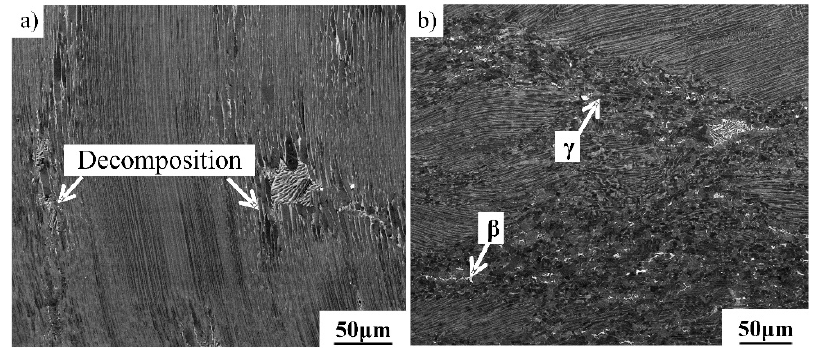
Figure 5. The e ff ect of deformation magnitude on the microstructural evolution